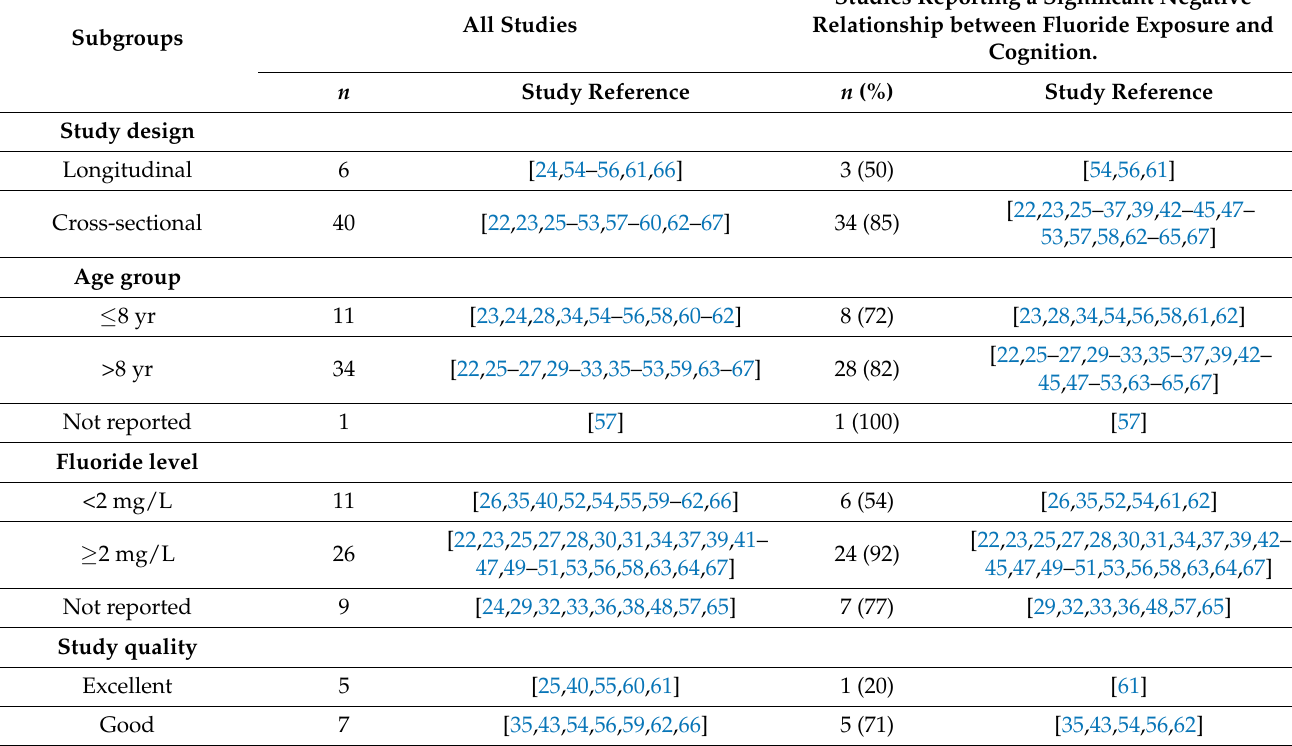
Table 1. Number of studies by subgroup